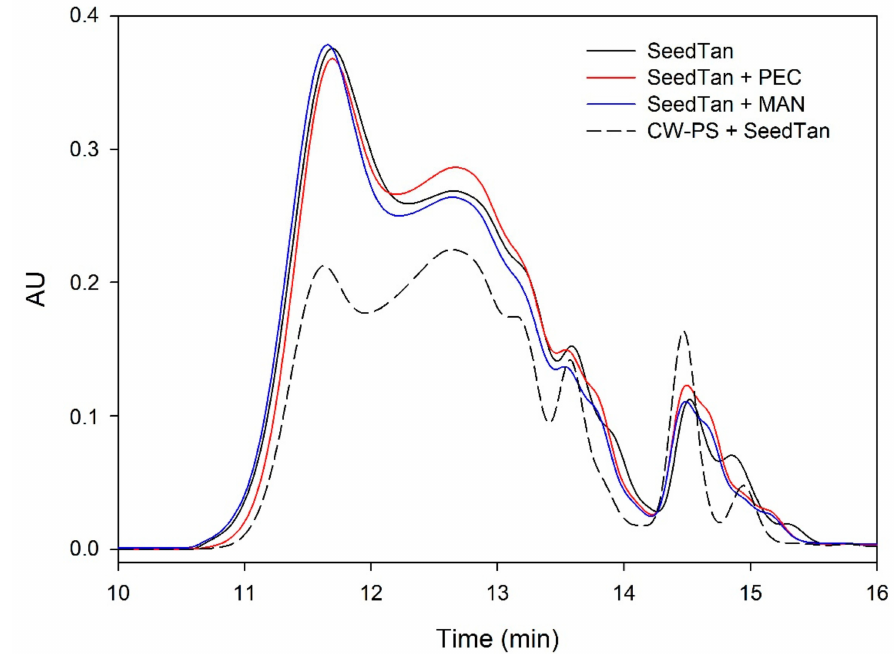
Figure 3. Analysis of the mass distribution of seed tannins by SEC. Comparison of the seed tannins in the absence (SeedTan) and presence of PEC, MAN, and PS-CW.